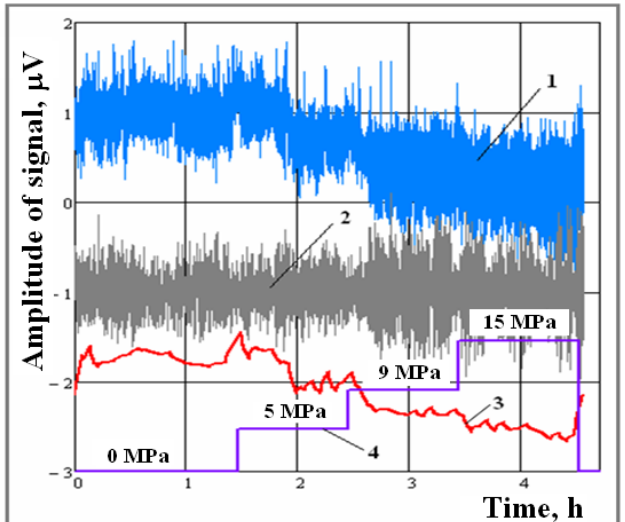
Figure 2.(1) Processing of the detected signal obtained by uniaxial tension of aluminum sample using a wavelet filter. (2) Noise component of the signal.(3)The signal without noise is shifted down from the noise axis by one unit. (4) Sample loading